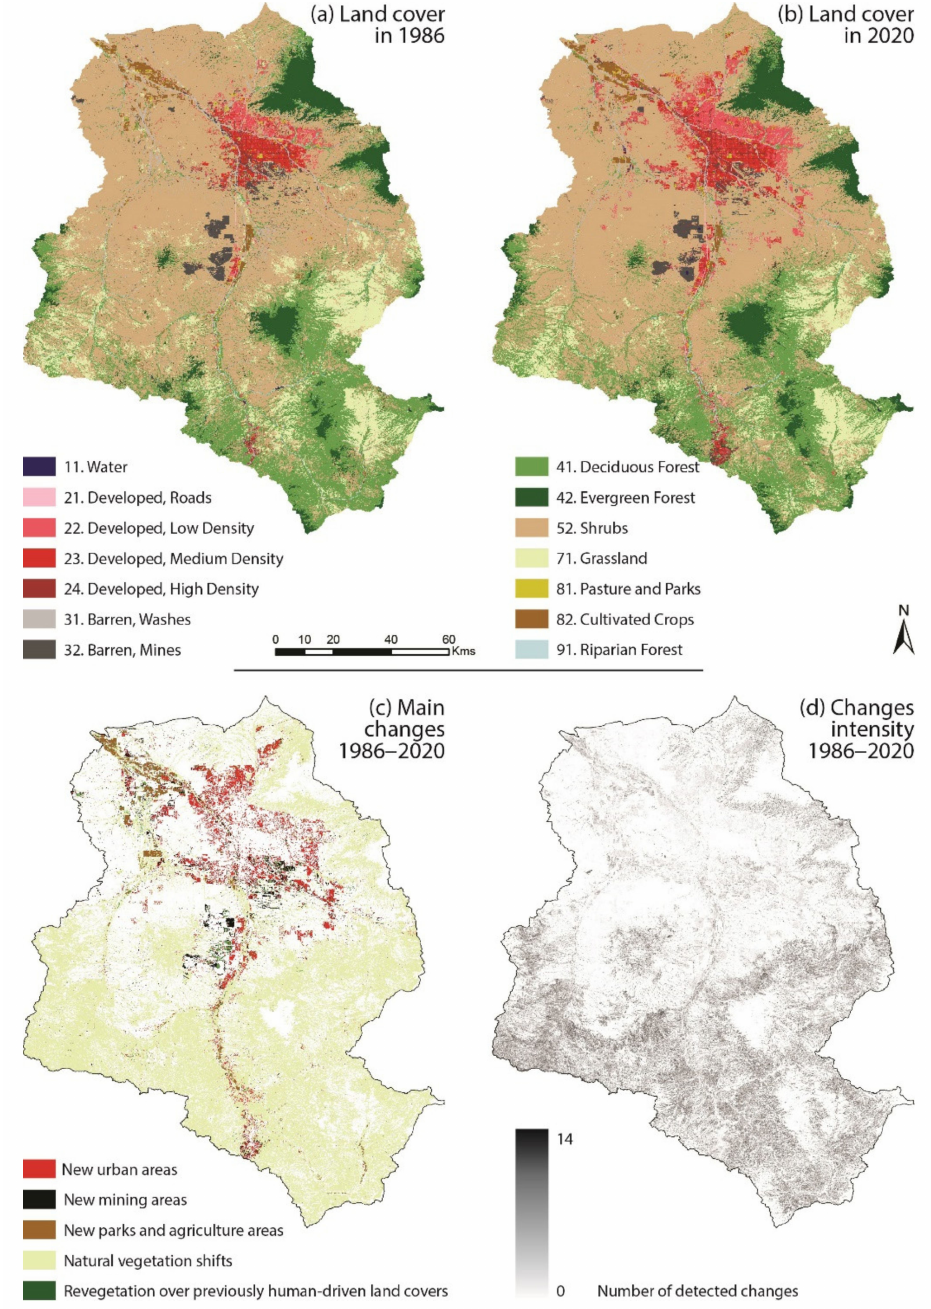
Figure 4. LULC change dynamics showing ( a ) land cover in 1986, ( b ) land cover in 2020, ( c ) major changes between 1986 and 2020 and ( d ) the intensity of change during the 1986–2020 period, which refers to the number of times the pixel changed major